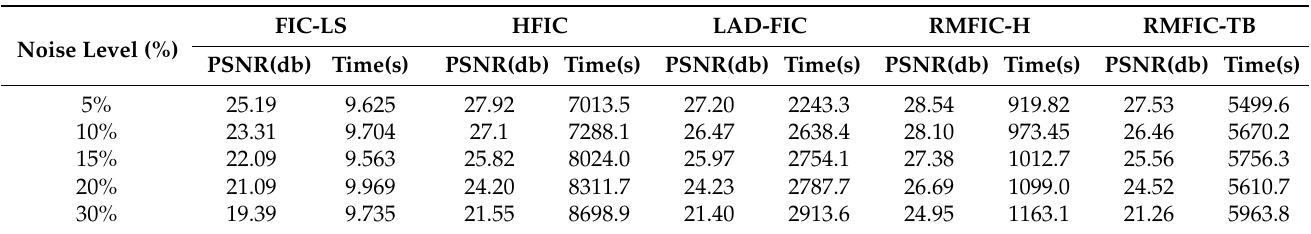
Table 1. Performance of full search FIC-LS, HFIC, LAD-FIC, RMFIC-H, and RMFIC-TB with salt and pepper